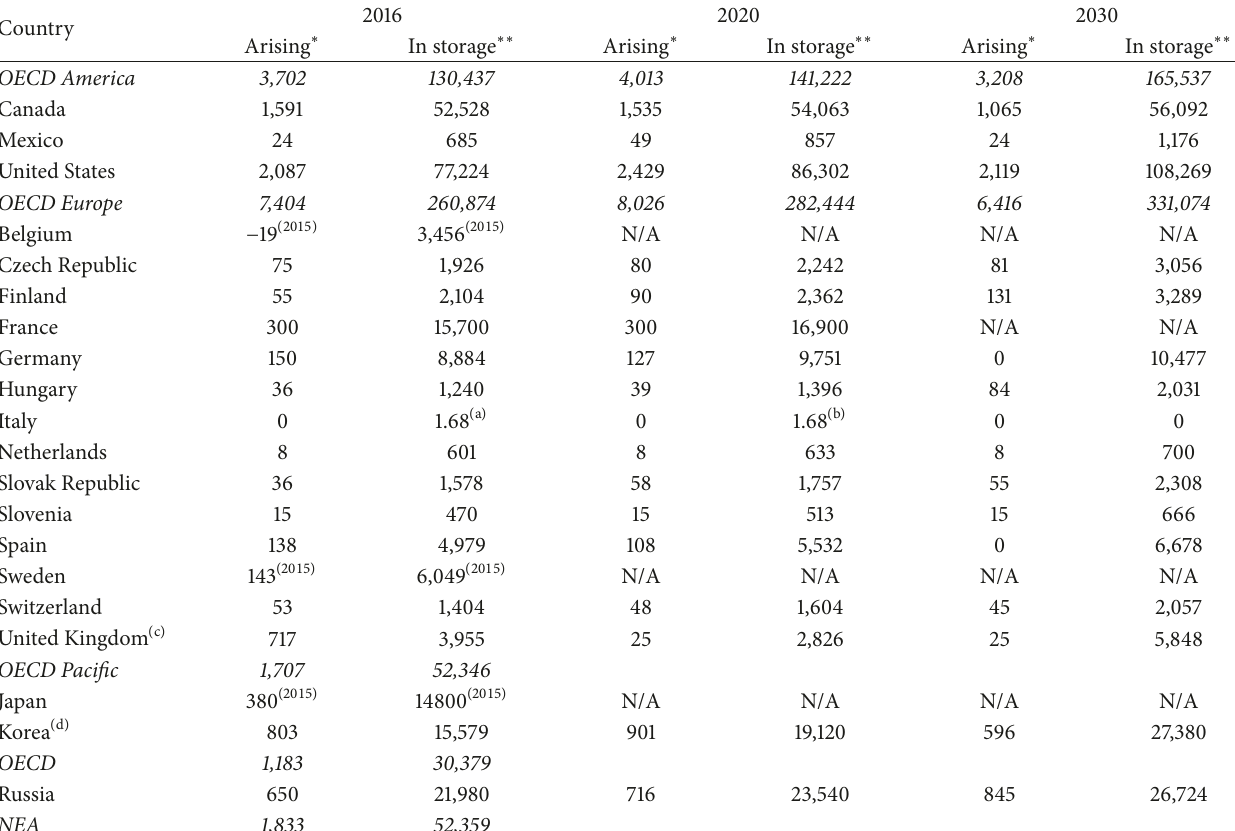
Table 1: SNF-produced and cumulative inventory in storage in 2016, 2020, and 2030 [6].